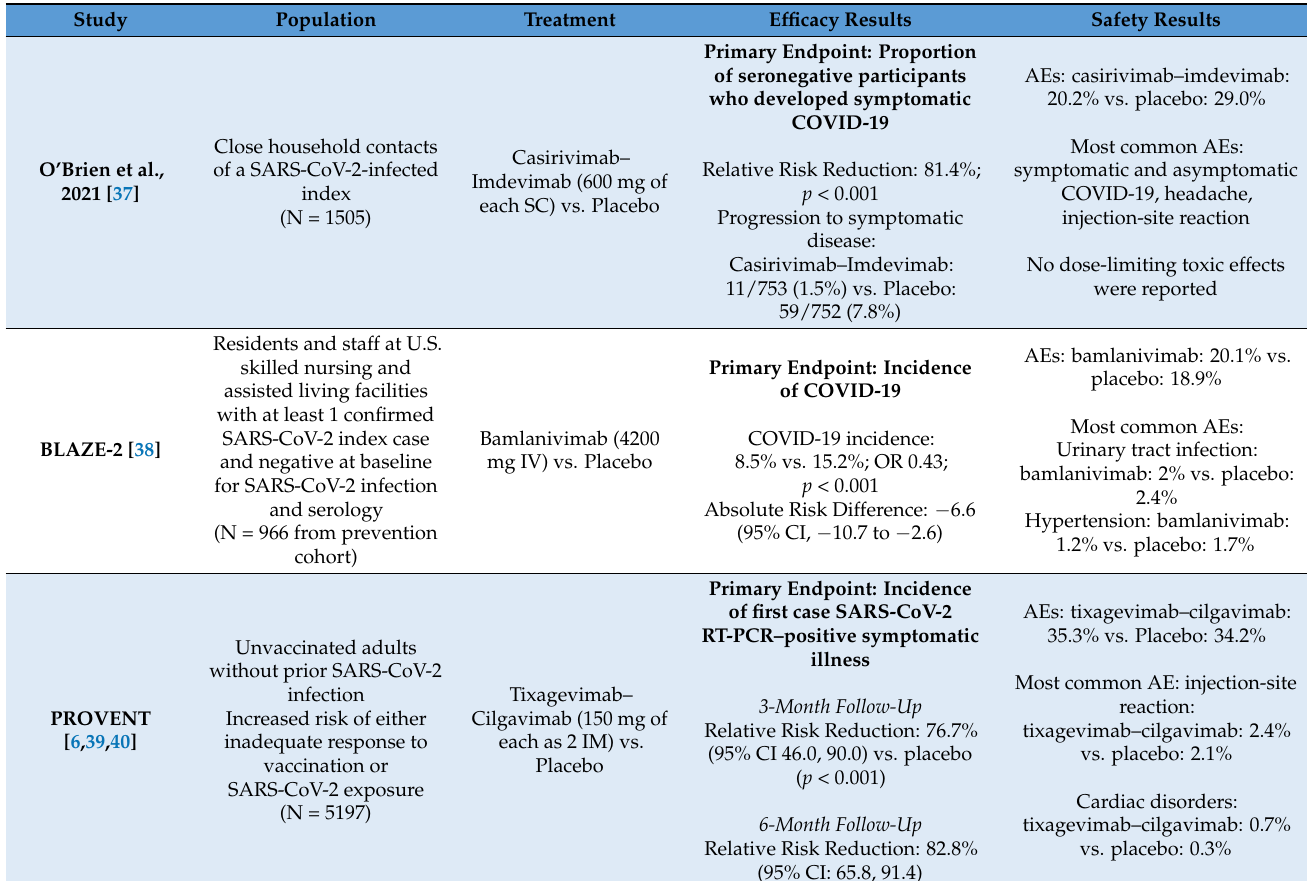
Table 2. Key Phase 3 Trials of Pre- and Post- COVID-19